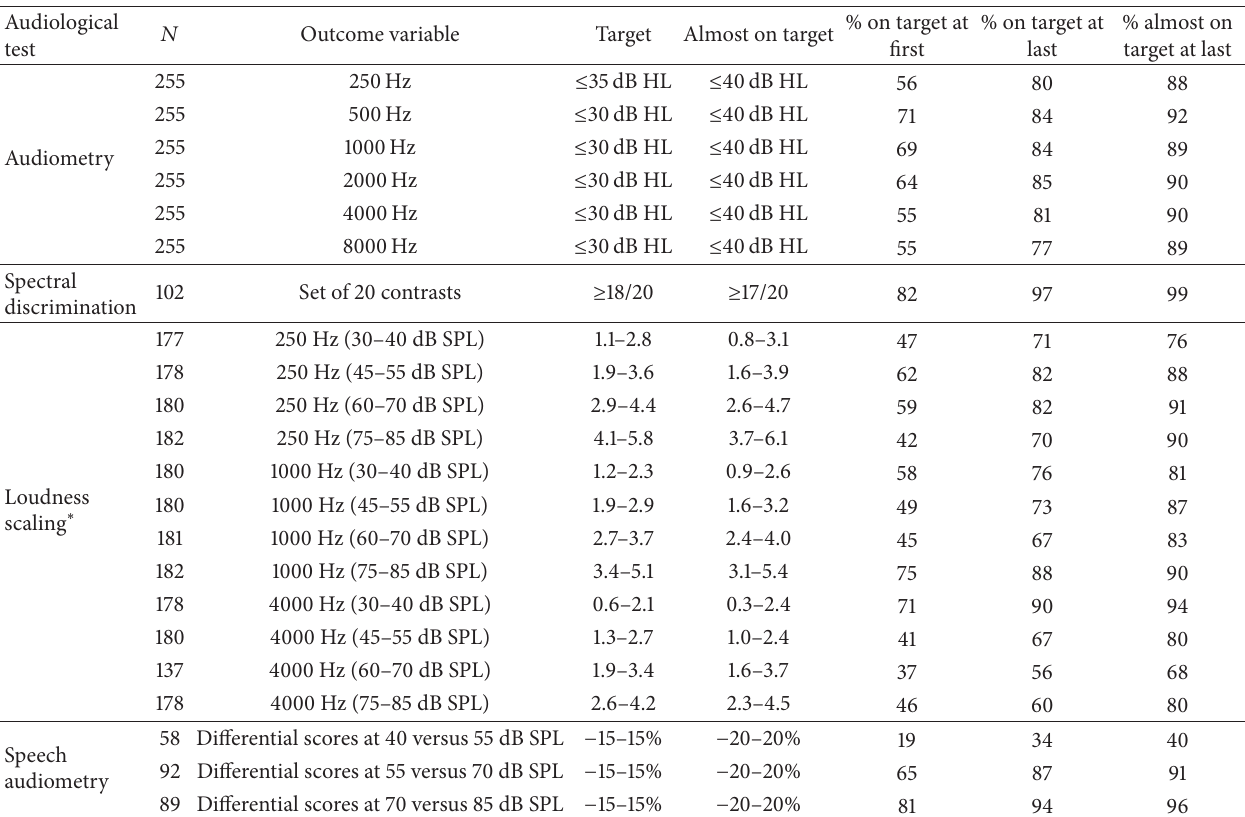
Table 2: Overview of outcome variables with value definitions for target and close to